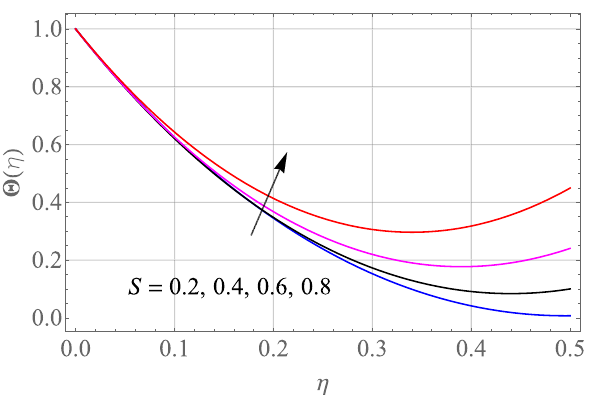
Figure 10. Alterations in �(η) as S raises. When M = 0.1, Pr = 6.2, Gc = 0.2, Ec = 1, Nb = Nt = 0.3, Sc = 0.3 .